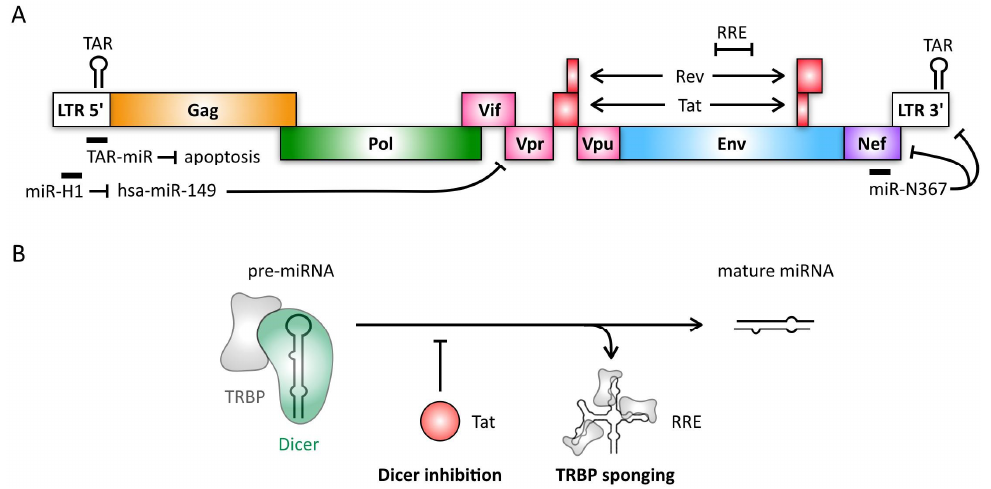
Figure 2. Genome organization of HIV-1 and strategies for suppression of RNA silencing. ( A ) The proviral DNA genome of HIV-1 encodes three structural genes ( gag , pol and env ) and several accessory genes ( vif , vpr , vpu , tat , rev and nef ) which regulate expression of viral proteins and play roles in immune evasion. The genome is flanked by long terminal repeats (LTRs), required for genome integration. Three functional miRNAs are encoded in the LTR region and Nef, which inhibit host and viral gene expression. The LTRs include the transactivation response (TAR) element stem-loop structure which can also be recognized by Dicer and TRBP and processed into TAR-miR-5p and -3p. ( B ) HIV-1 acts as a suppressor of RNA silencing. The Tat protein inhibits processing of pre-miRNAs by inhibiting Dicer activity. The Rev-response element (RRE) is a structured RNA element that resembles precursor miRNAs, able to compete with pre-miRNAs for TRBP binding.